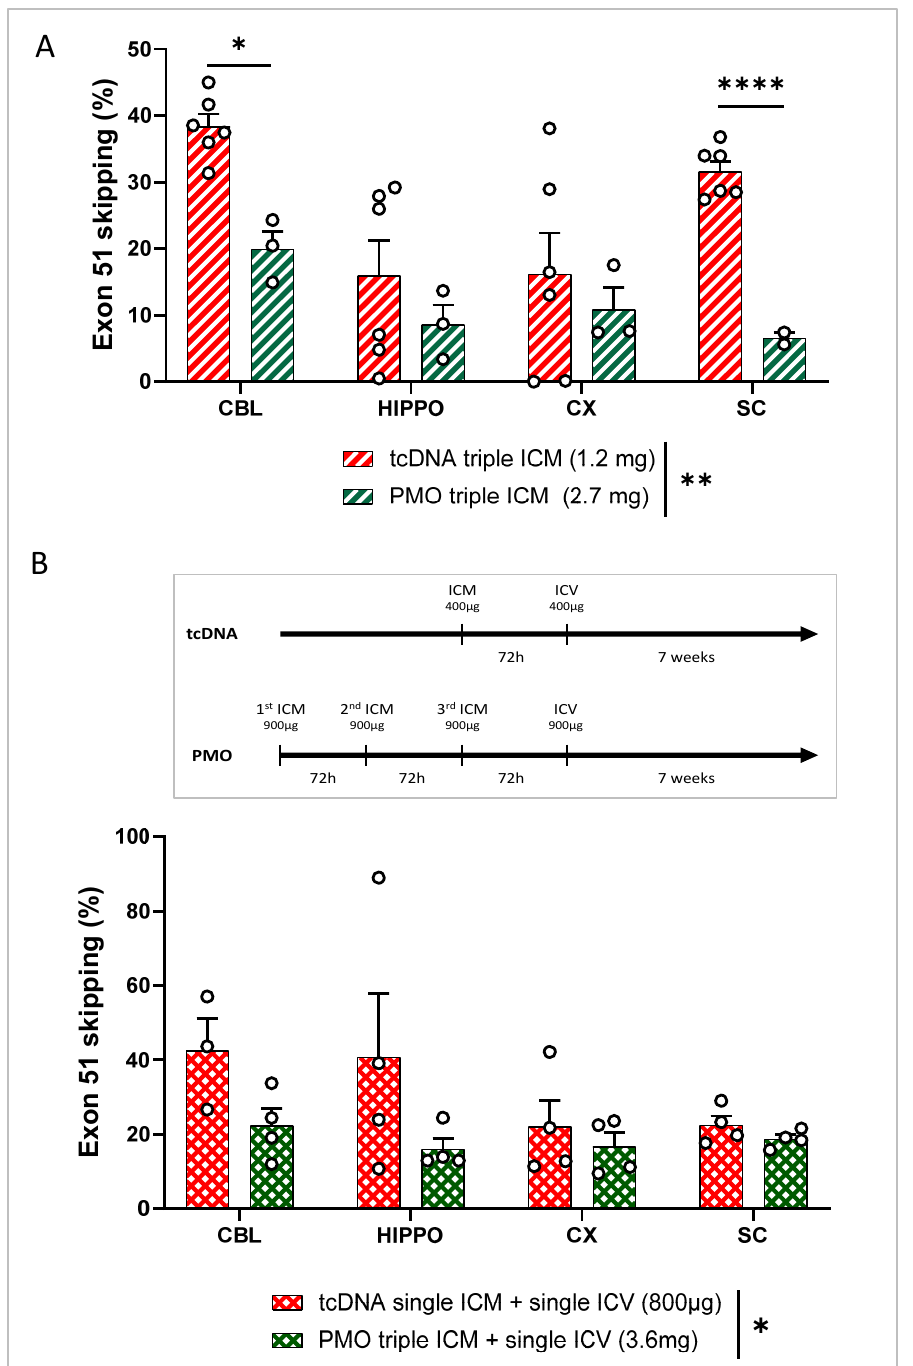
Figure 4. Repeated ICM delivery and combined ICM and ICV delivery of tcDNA or PMO in the CNS of mdx52 mice. ( A ) Quantification of exon 51-skipping levels via RT-qPCR in different brain regions (CBL: cerebellum, CX: cortex, HIPPO: hippocampus, and SC: spinal cord) after PMO or tcDNA triple ICM 7 weeks after administration. Results are expressed as means ± SEMs; n = 6 mdx52 -tcDNA and n = 3 mdx52 -PMO. RM two-way ANOVA: structure effect p = 0.0182, ASO chemistry effect ** p = 0.0054. ( B ) Quantification of exon 51-skipping levels via RT-qPCR in different brain regions (CBL: cerebellum, CX: cortex, HIPPO: hippocampus, and SC: spinal cord) after PMO triple ICM + ICV injection and tcDNA single ICM + ICV injection, analyzed 7 weeks after administration. Results are expressed as means ± SEMs; n = 4 mdx52 -tcDNA and n = 4 mdx52 -PMO. RM two-way ANOVA: structure e ff ect p = 0.3012, ASO chemistry e ff ect * p = 0.0209. (* p < 0.05, **** p < 0.0001).